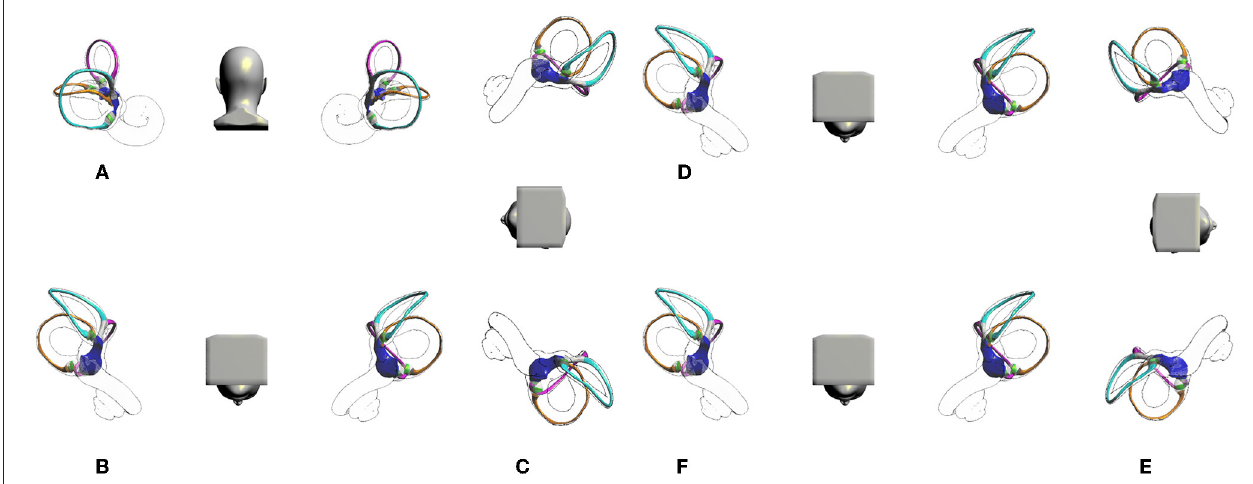
FIGURE 4 | Prone roll maneuver. (A) Upright position. (B) Tilted forward 90 ◦ , prone position. (C) Turn head 90 ◦ to one side (right lateral position). (D) Return to the prone position. (E) Turn head 90 ◦ to the other side (left lateral position). (F) Return to the prone